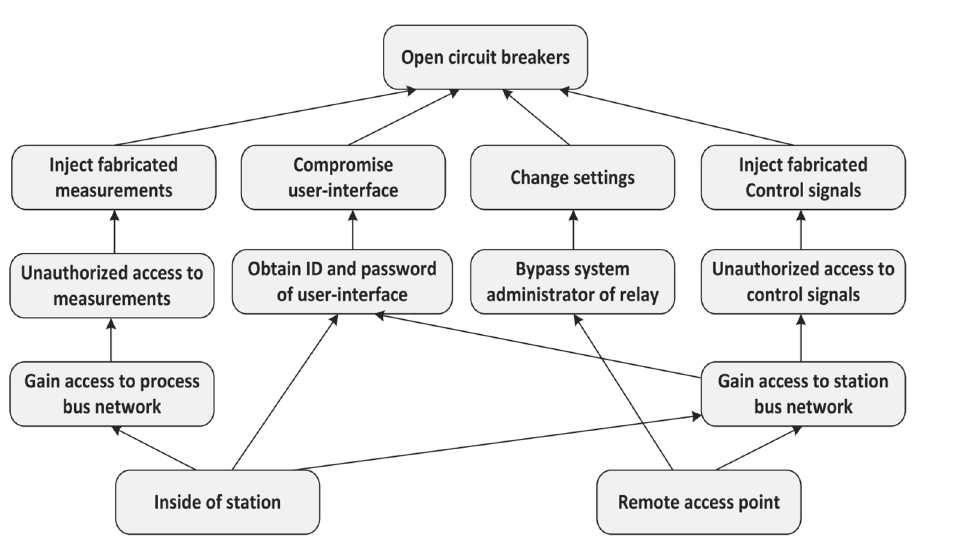
Figure 10. Attack tree showing the paths for potential cyberattacks 15